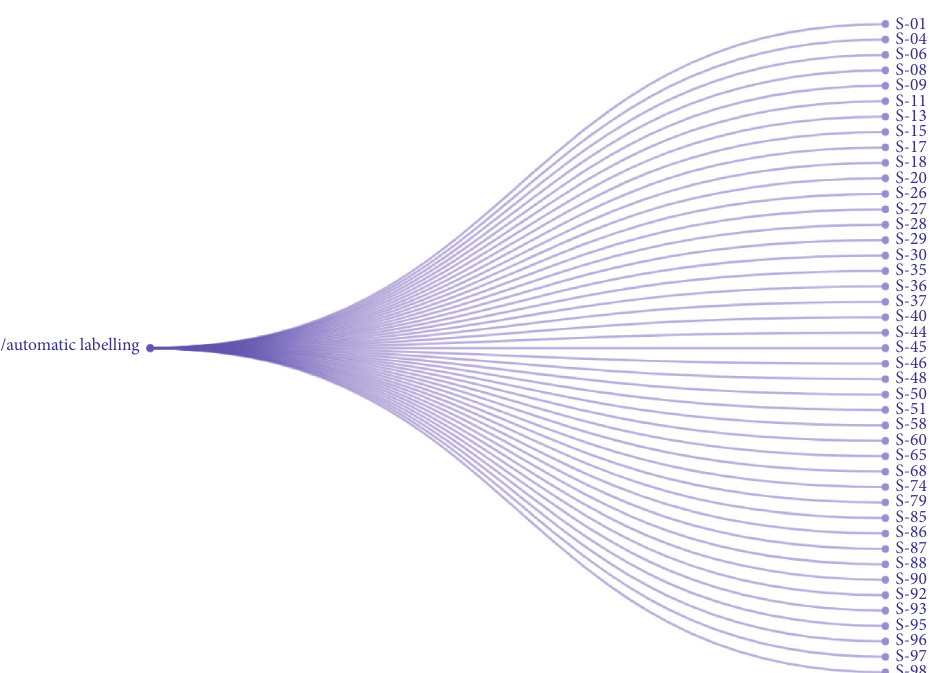
Figure 10: List of studies reporting manual/automatic data